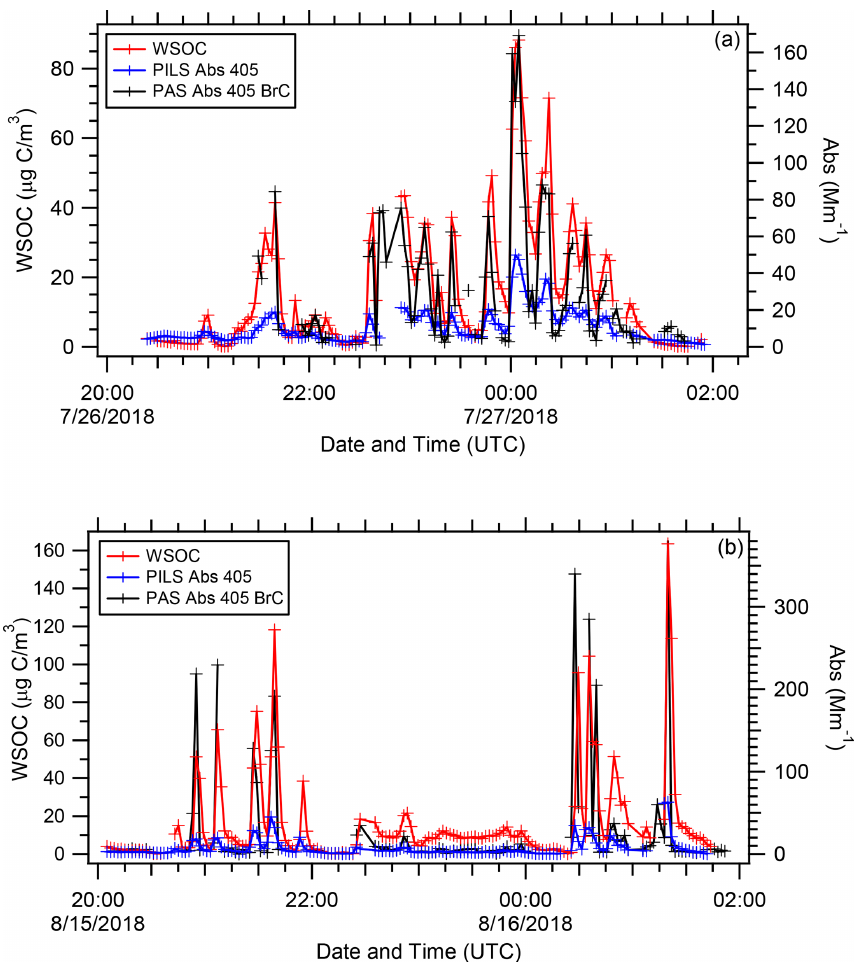
Figure 3. Time series of WSOC, PILS water-soluble Abs 405, and PAS total Abs 405 BrC for WE-CAN (a) flight RF02 and (b) flight